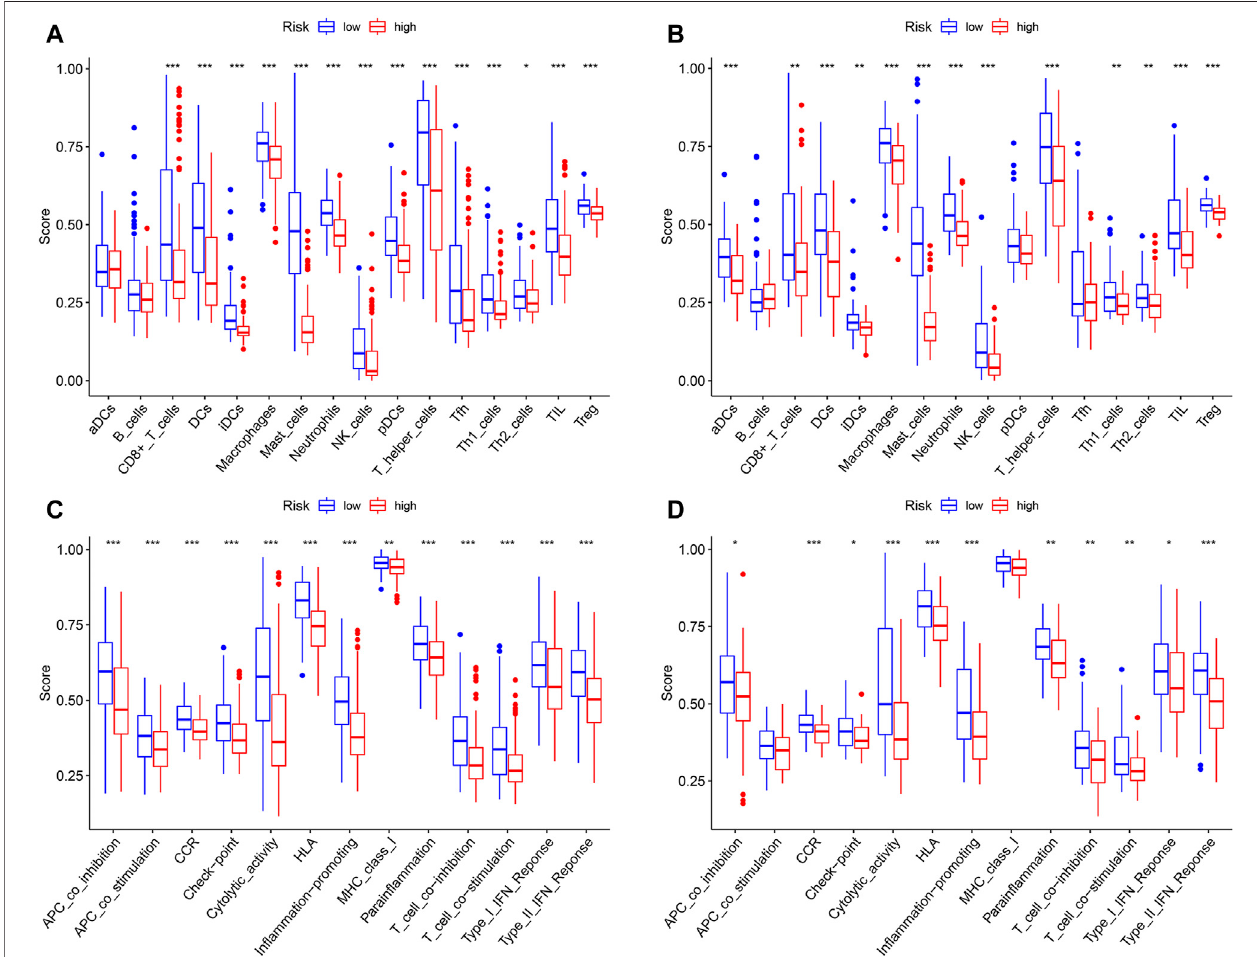
FIGURE 7 | Analysis of immune status based on pyroptosis-related risk score. (A, C) Comparisons of immune cells and immune functions between different risk groups in TCGA-SARC cohort. (B, D) Comparisons of immune cells and immune functions between different risk groups in GSE30929 cohort (* p < 0.05, ** p < 0.01, *** p <